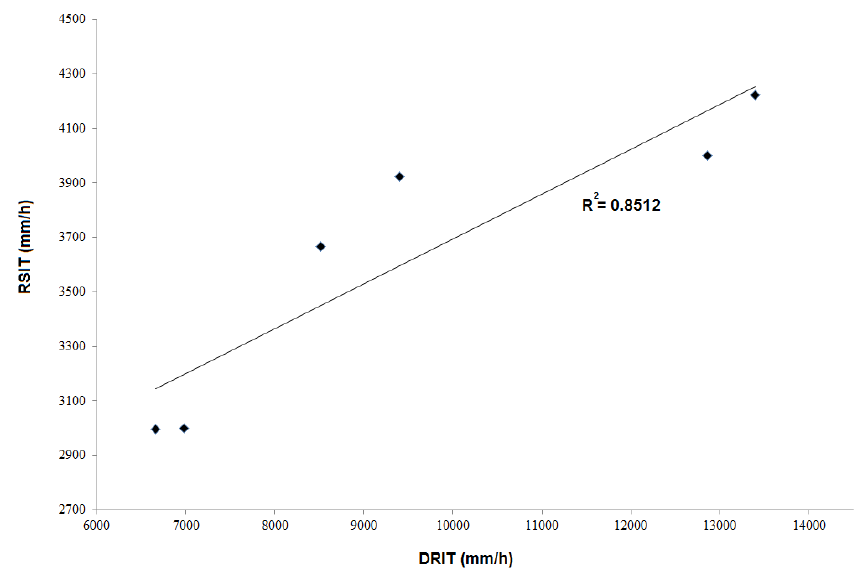
Figure 7. Regression analysis between DRIT and RSIT methods showing strong correlation of